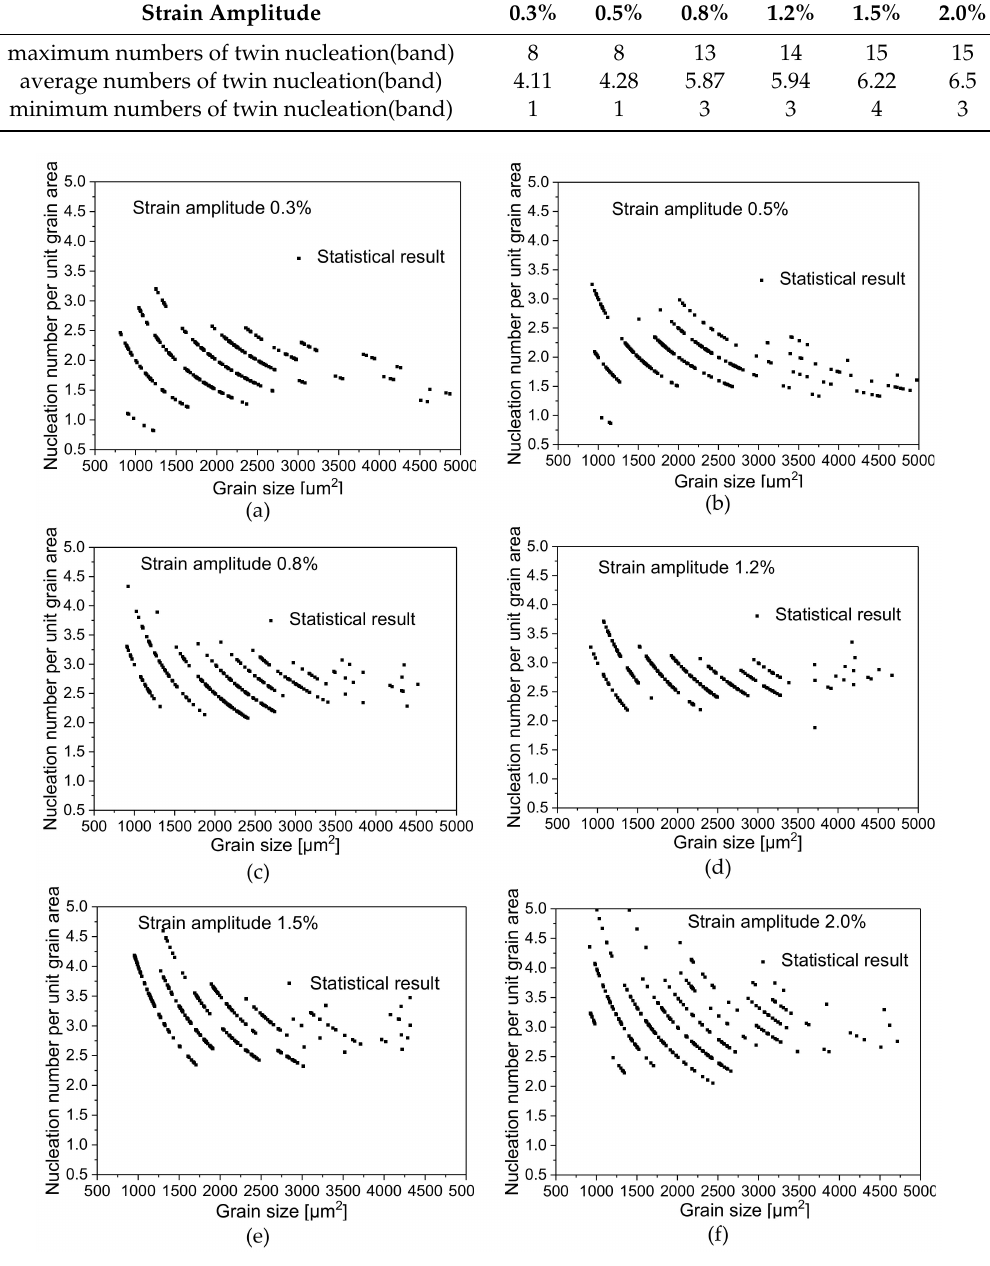
Figure 8. Distribution diagram of TNN under per unit grain size area at di ff erent strain amplitudes: ( a ) 0.3%; ( b ) 0.5%; ( c ) 0.8%; ( d ) 1.2%; ( e ) 1.5%; ( f )